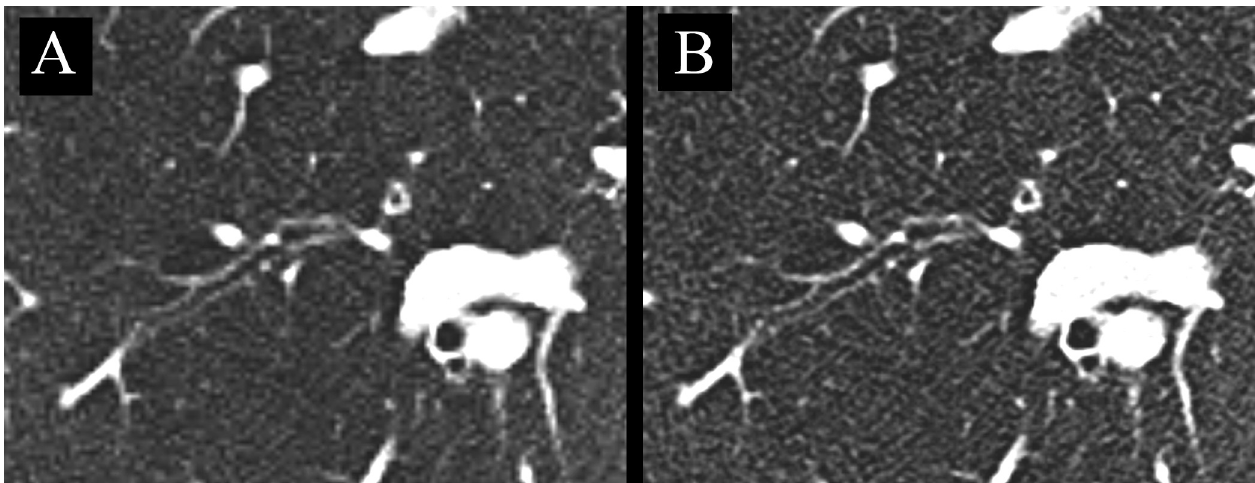
Fig 6. Image example of an axial CT slice of the same patient reconstructed with a 512-matrix (A) and 1024-matrix (B). Note the improved sharpness of the bronchial wall but increased image noise in B compared to A. Even though step artifacts are present in A, readers gave similar ratings for overall image quality of bronchial structures.